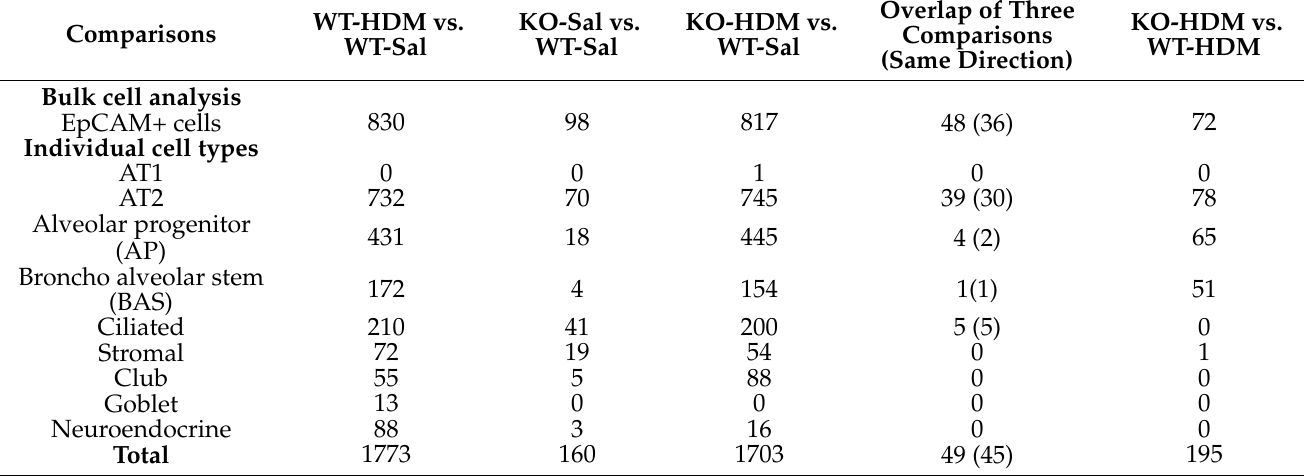
Table 1. Number of differential expression genes (DEGs) of EpCAM +